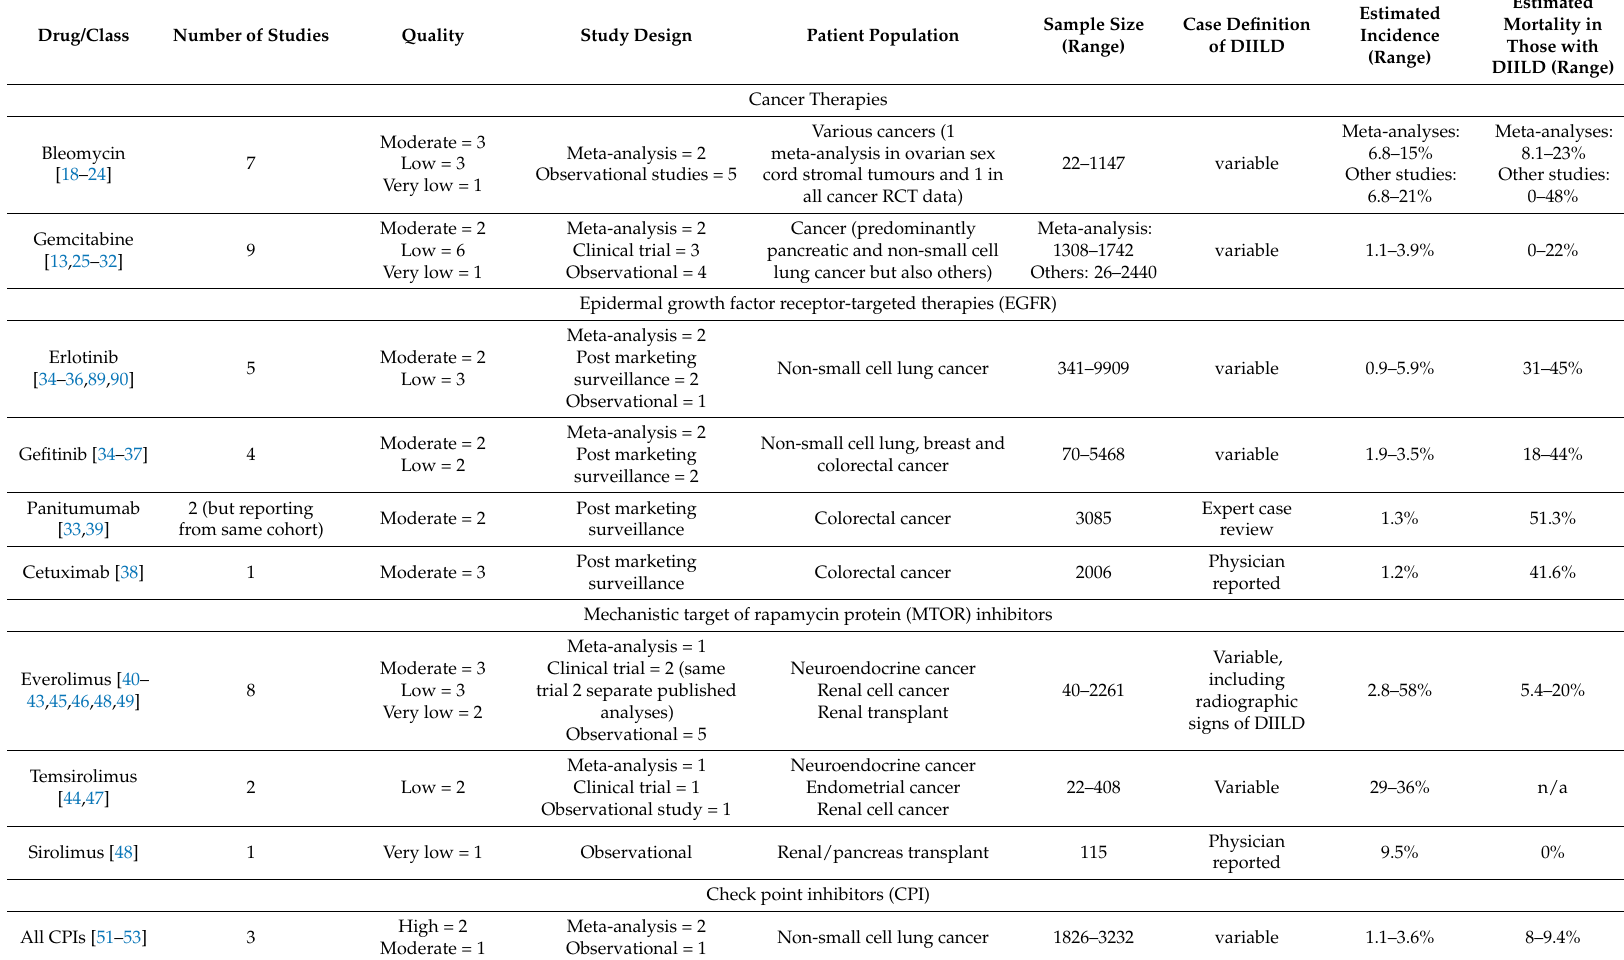
Table 2. Summary of specific classes or agents associated with DIILD identified from literature review of lung